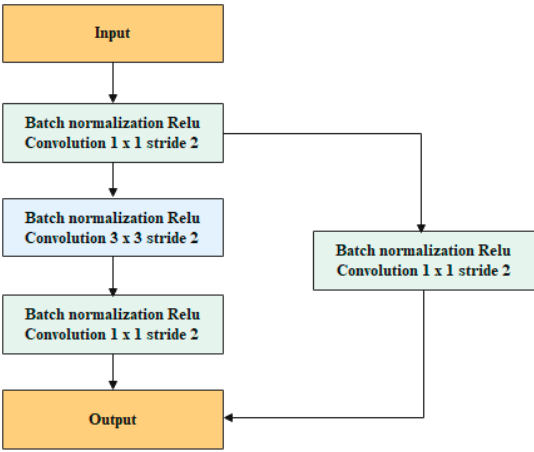
Figure 6. The structure of the bottleneck block.